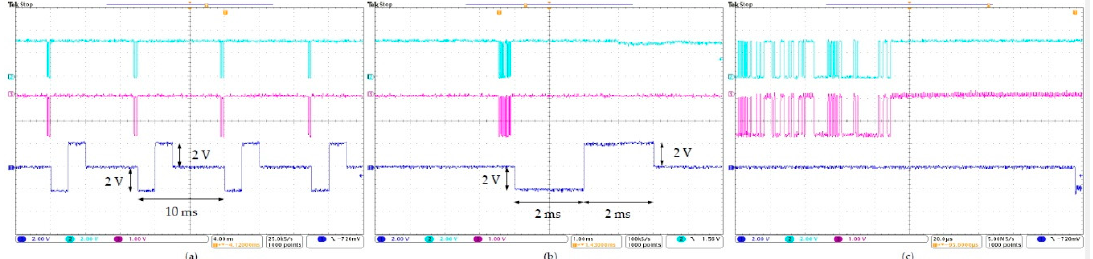
Figure 7. Stimuli of 100 Hz, 2 mA, and 2 ms were generated by the wireless GI modulation system on the bench top. Cyan, pink, and blue traces are command sent from microcontroller unit (MCU) in the RD, command demodulated by differential phase shift keying (DPSK) receiver in EGMD, and the induced output voltage waveform, respectively. Traces presented in time period of ( a ) 40 ms, ( b ) 10 ms, and ( c ) 200 μ s.